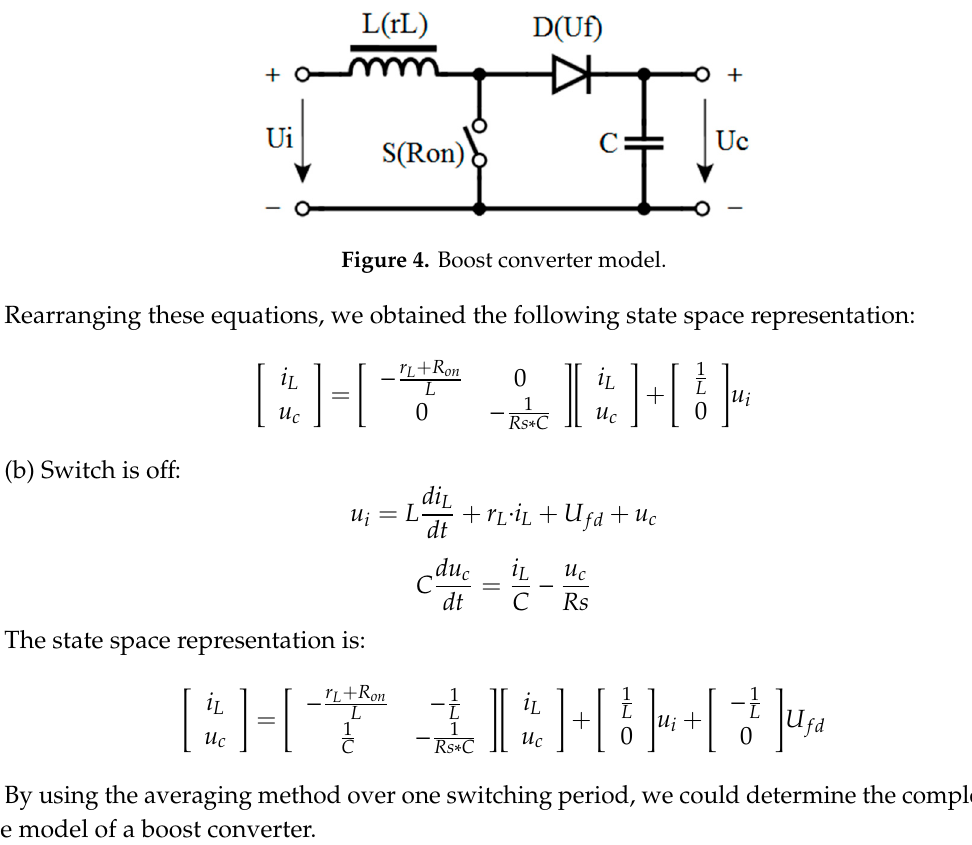
Figure 4. Boost converter model.